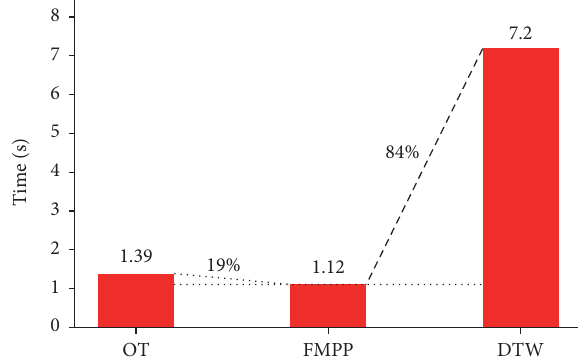
Figure 16: The test results of the time consumed by FMPP and comparison